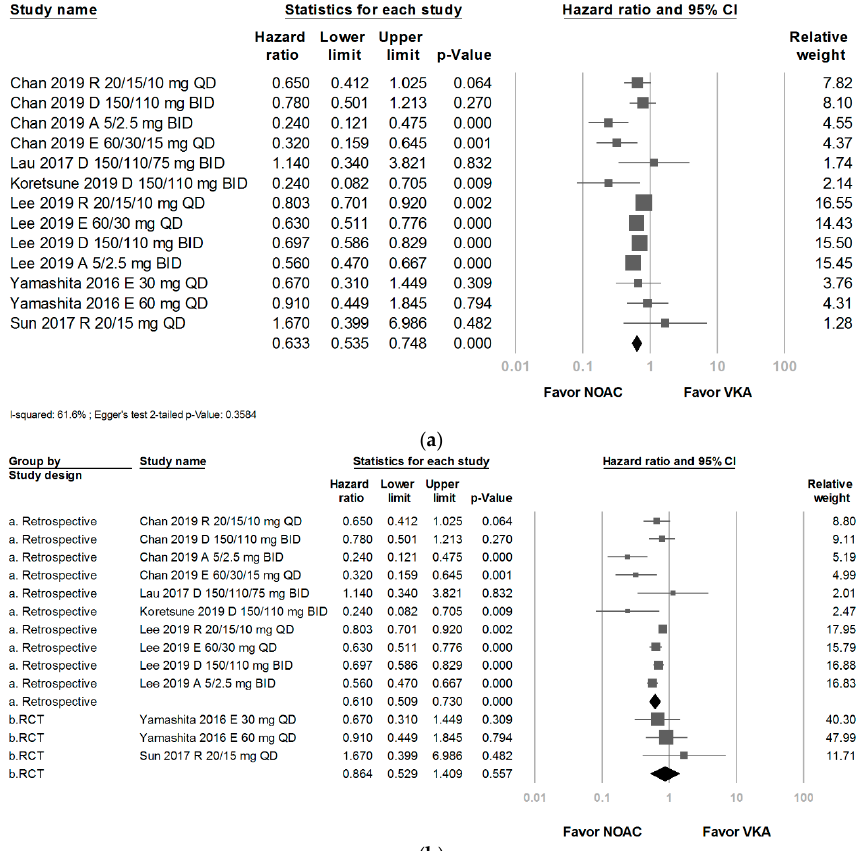
Figure 3. ( a ) Forrest plot of comparison: all novel oral anticoagulants versus vitamin K antagonists. ( b ) Forrest plot of comparison: the retrospective studies subgroup and the RCTs